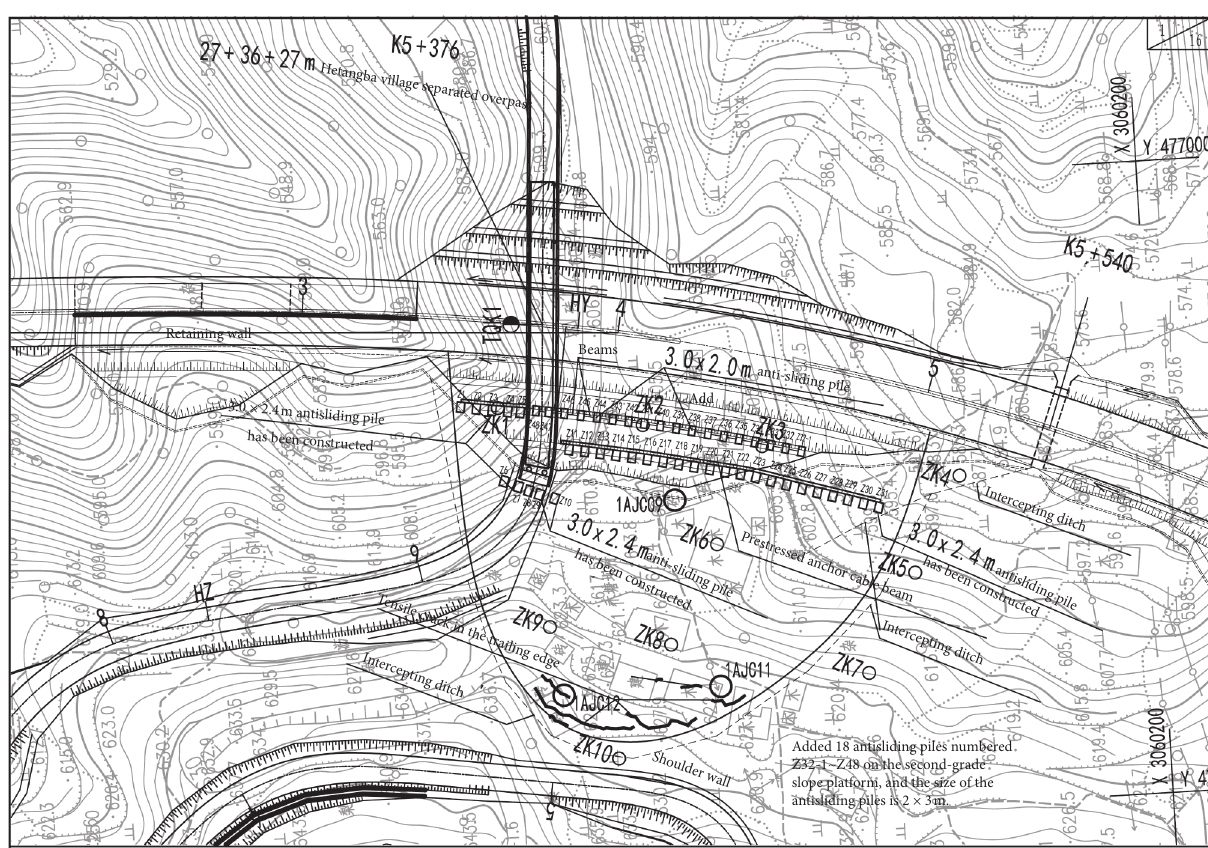
Figure 1: Schematic of deep hole displacement monitoring locations.